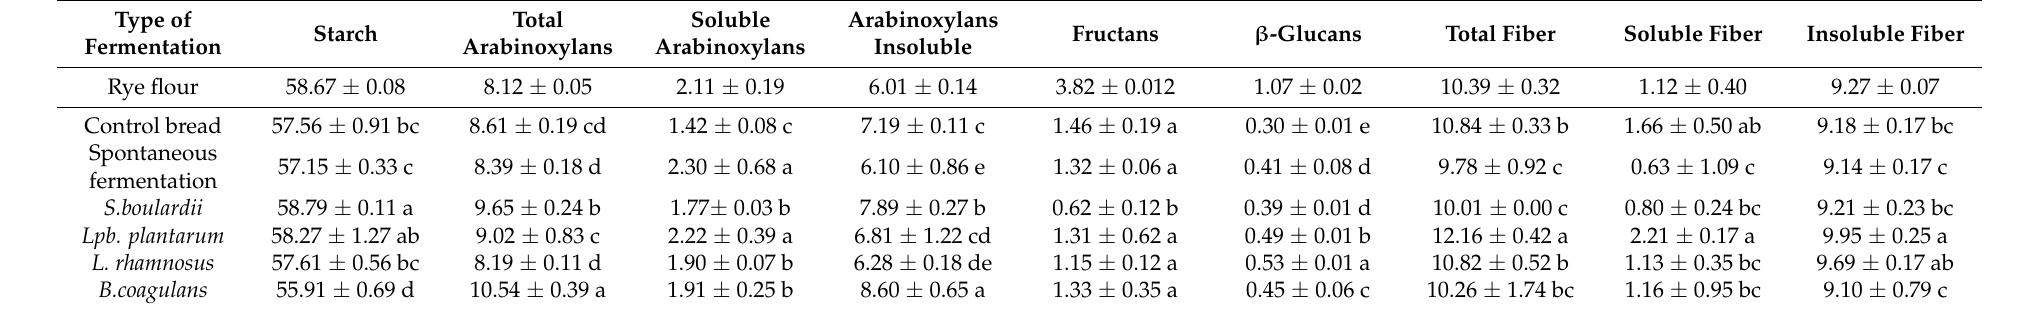
Table 1. The contents of individual polysaccharides and dietary fiber in the dry matter of the rye flour and sourdough breads [%